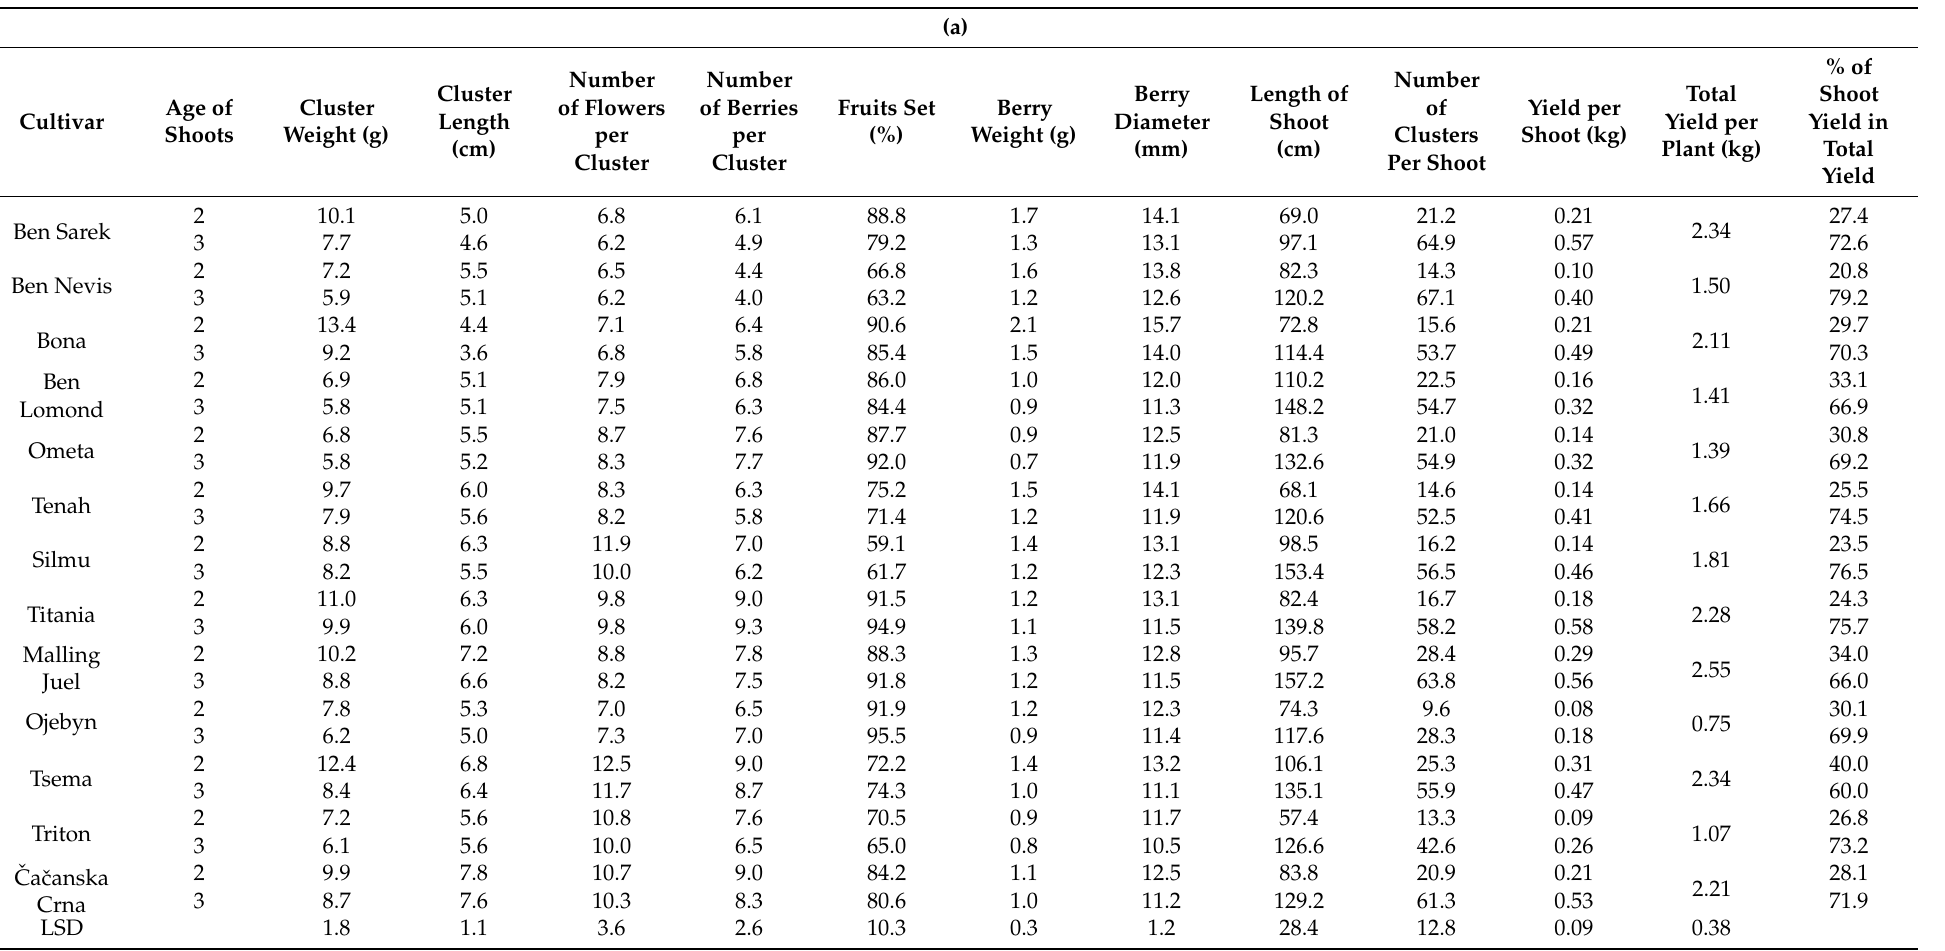
Table 2. ( a ) Physical attributes of clusters and berries of 13 studied black currant cultivars (2018). ( b ) Physical attributes of clusters and berries of 13 studied black currants cultivars